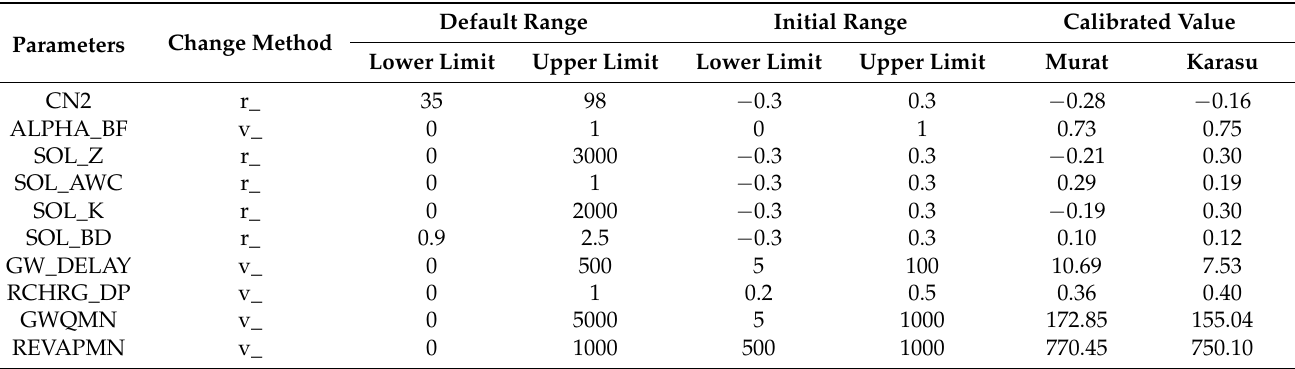
Table 6. Calibrated parameters with change methods and initial